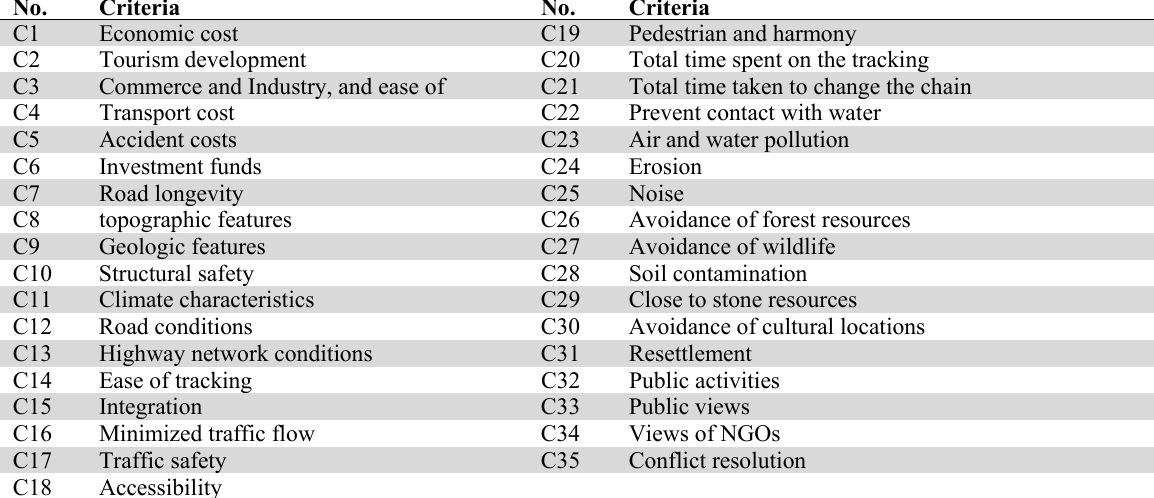
Evaluation Criteria for Optimal Route Variant